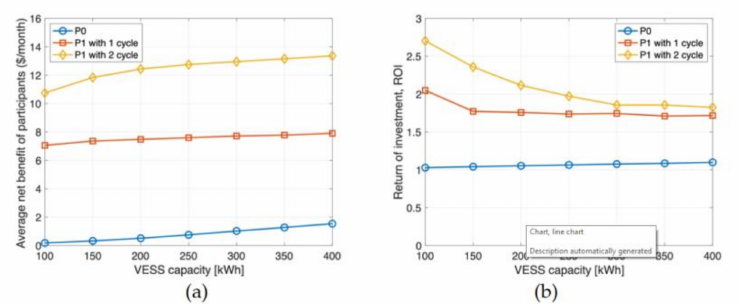
Figure 3. Performance comparison of the VESS operation according to P0 and P1 with varying VESS capacity: ( a ) average net benefit of participants; ( b ) return of investment of